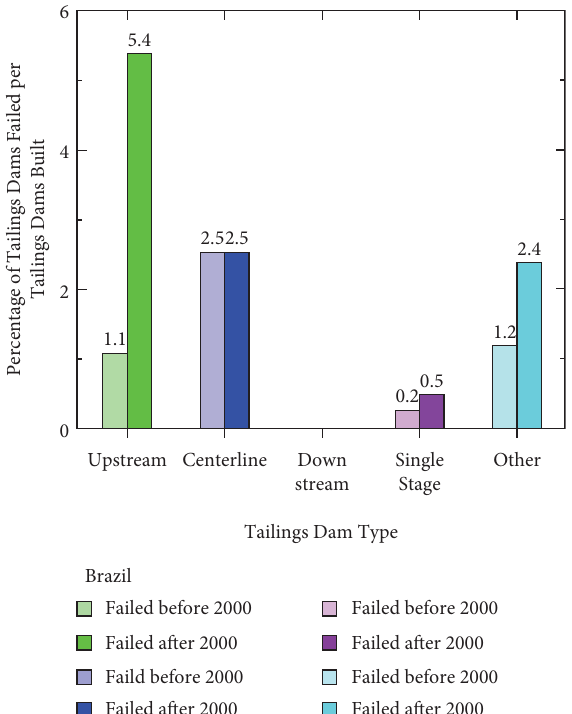
Figure 3: Percentage of tailings dams failed per tailings dams built in Brazil, before and after 2000, according to dam type (data from Bowker [22] and Agˆencia Nacional de Mineração